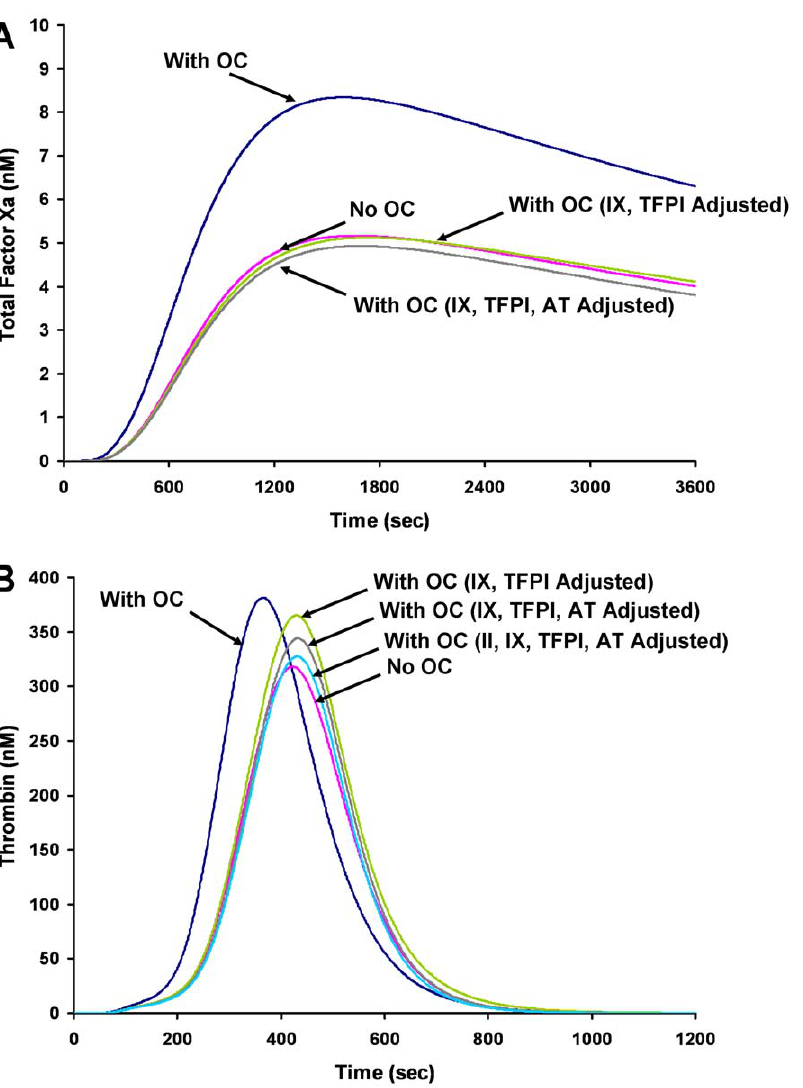
Figure 6. Factor Xa and thrombin generation curves for oral contraceptive users and non-users. Panel A: Factor Xa curves for oral contraceptive users, non-users, users with fIX and TFPI adjusted to the mean value of the non-users and users with fIX, TFPI and AT adjusted to the mean value of the non-users. Panel B: Thrombin curves for oral contraceptive users, non-users, users with fIX and TFPI adjusted to the mean value of the non-users, users with fIX, TFPI and AT adjusted to the mean value of the non-users and users with fIX, TFPI, AT and fII adjusted to the mean value of the non-users.